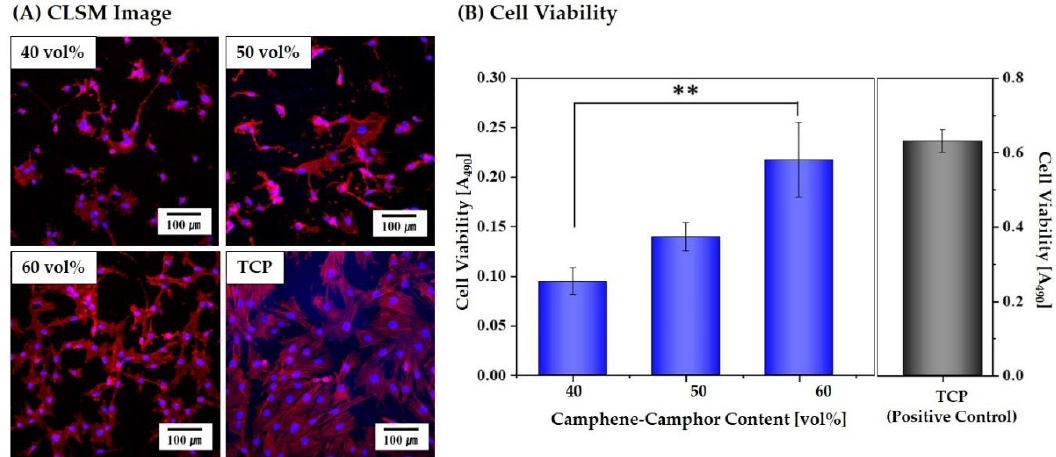
Figure 11. (A) Representative confocal laser scanning microscopy (CLSM) images of the MC3T3 cells adhered to and spread on the microporous CaP frameworks obtained using a range of camphene-camphor amounts (40 vol %, 50 vol %, and 60 vol %) after one day of cell culturing and ( B ) cell viabilities after three days of cell culturing. Tricalcium phosphate (TCP) was also tested as the positive control. Five samples were tested for each condition (* p < 0.05 and ** p < 0.01).